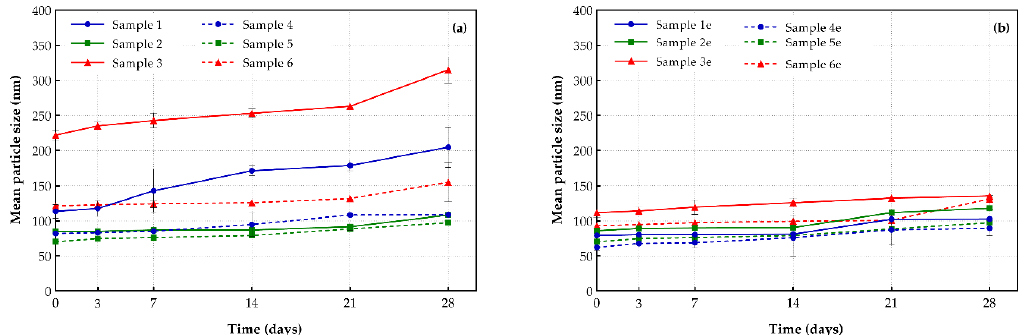
Figure 4. Mean particle size stability of ( a ) drug-loaded and ( b ) drug-free liposomal formulations (storage conditions: 4 °C, 28 days).